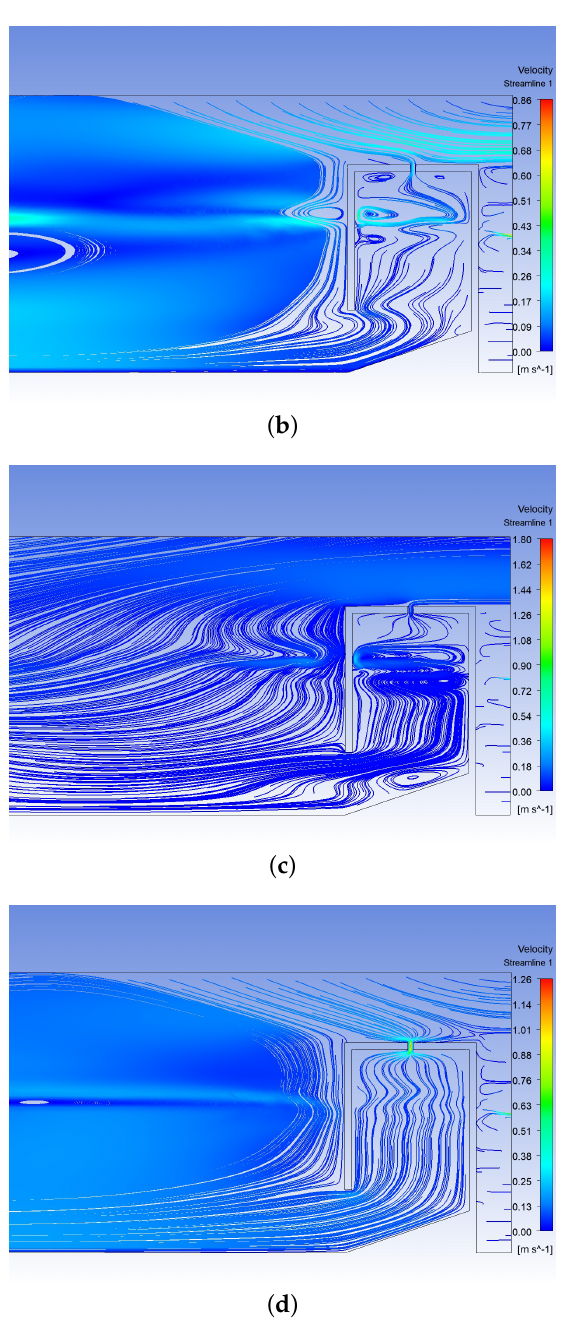
Figure 10. Streamline profile at various time instants: ( a ) t = 130 s, ( b ) t = 150 s, ( c ) t = 190 s, and ( d ) t = 210 s, with H s = 1.23 m and ω p = 0.811